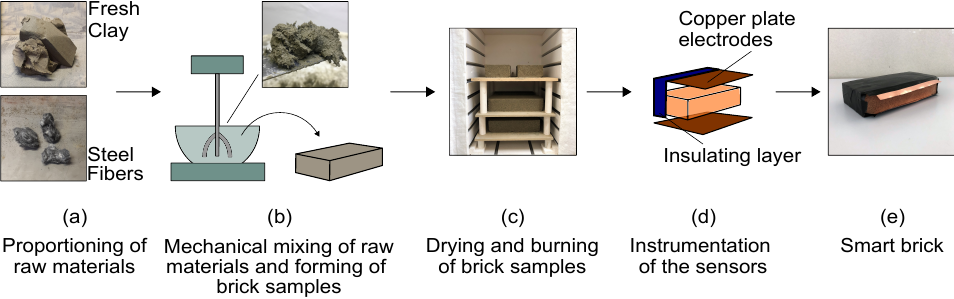
Figure 1. Production process of a sample of smart